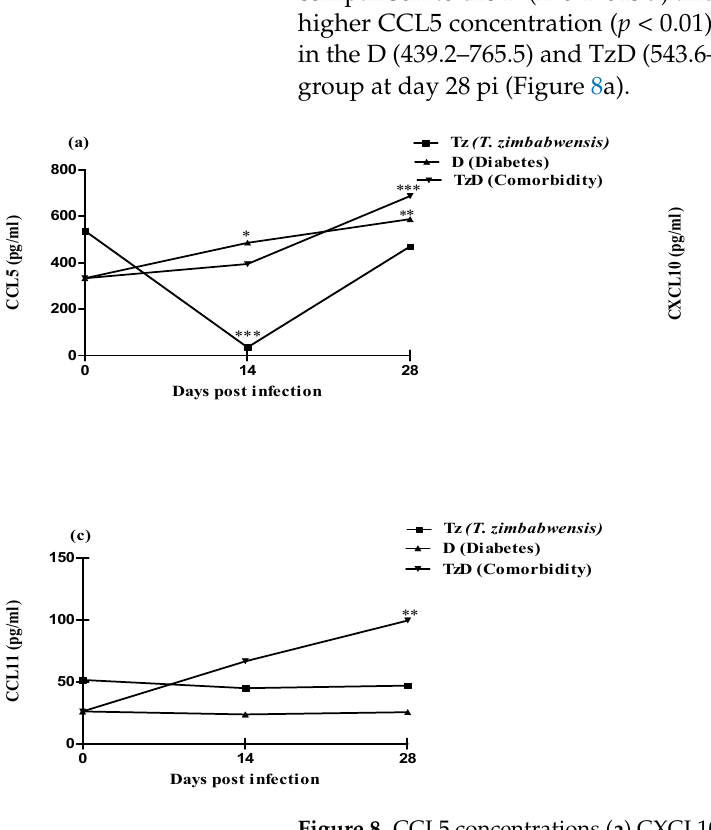
Figure 8. CCL5 concentrations ( a ) CXCL10 concentrations ( b ) and CCL11 concentrations ( c ) in male Sprague Dawley rats that were; comorbid with type 2 diabetes mellitus (TzD), diabetic (D) and infected with Trichinella zimbabwensis (Tz). Values are presented as mean ± SEM ( n = 6 in each group) and asterisks represent significant differences between the groups (* p < 0.05, ** p < 0.01, *** p < 0.001).